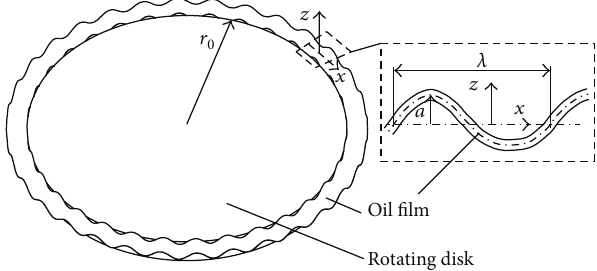
Figure 5: Schematic diagram of the oil film wave structure around rotating